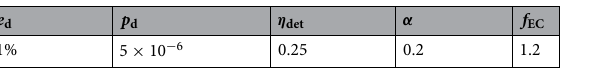
Table 1. Experimental parameters used in the simulations. The parameter e d is the intrinsic error rate due to the misalignment of the MDI-QKD system; p d is the dark count rate of the relay’s detectors, which we assume is equal for all of them; η det is the overall detection efficiency of the relay’s receiver; α is the loss coefficient of the channel measured in dB/km; and f EC is the efficiency of the error correction code.